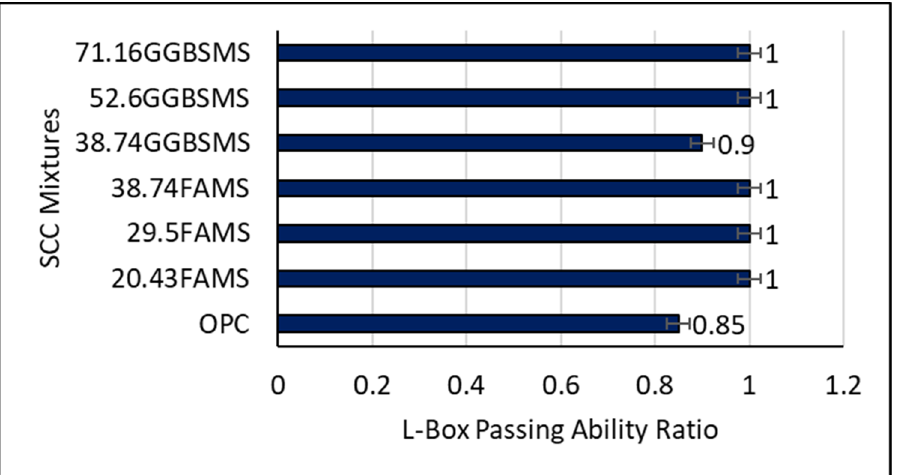
Figure 12. L-box test results (passing ability ratio).